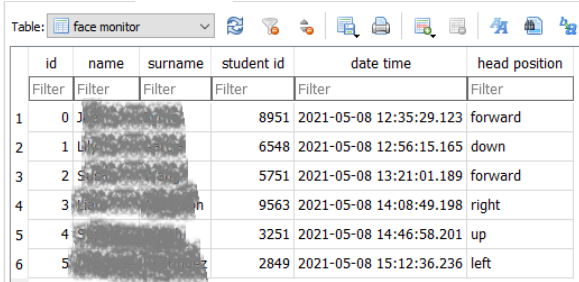
Figure 6 . Face Direction Tracking